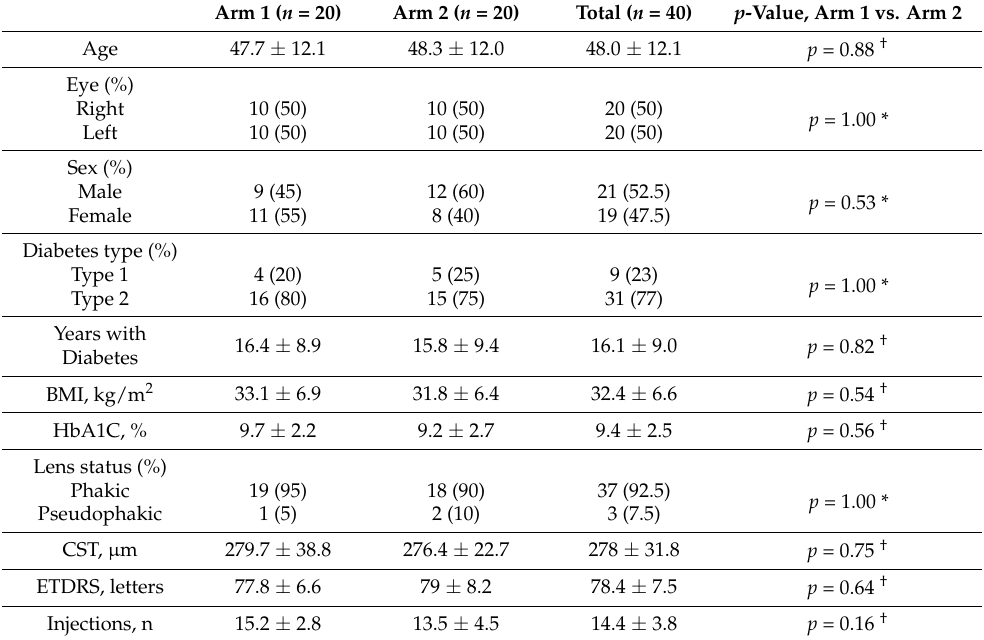
Table 1. Baseline Demographics and Ocular